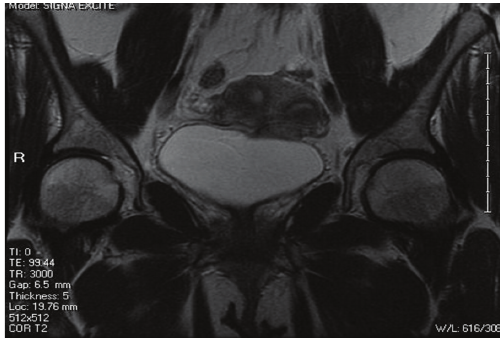
Figure 2: Coronal view; note the two uterine cavities, myometrium, and thick septum.